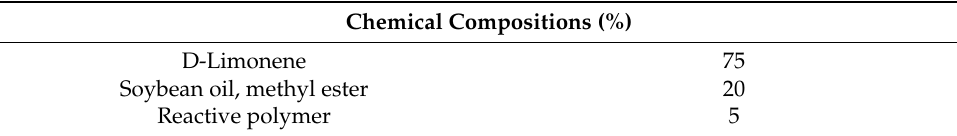
Table 3. Chemical properties of the asphalt